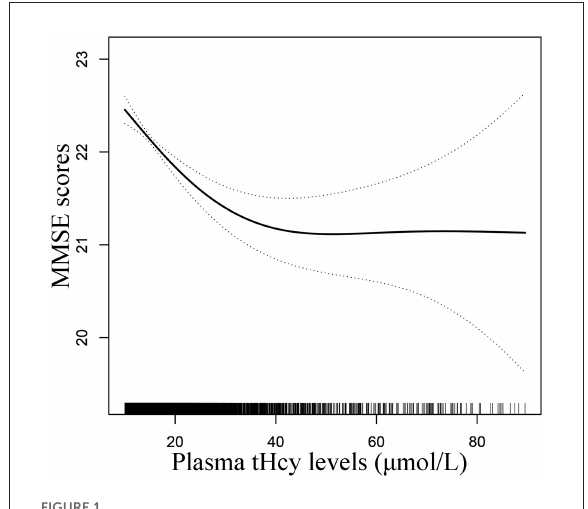
FIGURE1 Smooth curve of correlation between plasma tHcy levels and MMSE scores. Smooth curve adjusted for age, sex, education, BMI, smoking status, alcohol consumption, diabetes, CHD, antihypertensive drugs, SBP, DBP, total cholesterol, triglycerides, HDL-C, LDL-C, and